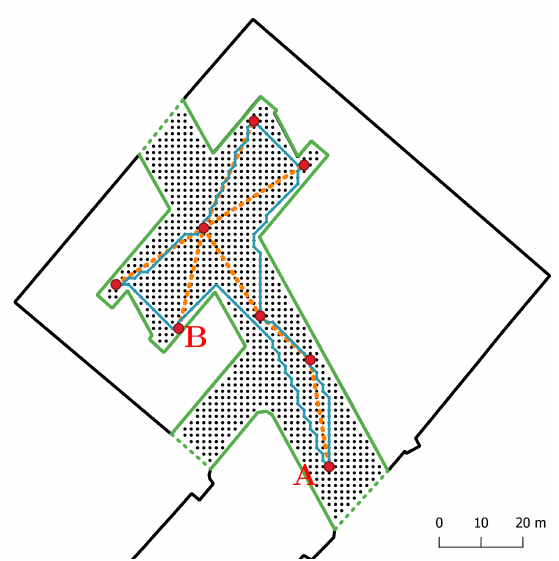
Figure 4. The Standpoints (red) calculated based on the candidate points lying on a grid (black dots), the connectivity graph for registration (orange) and the optimal route (blue).